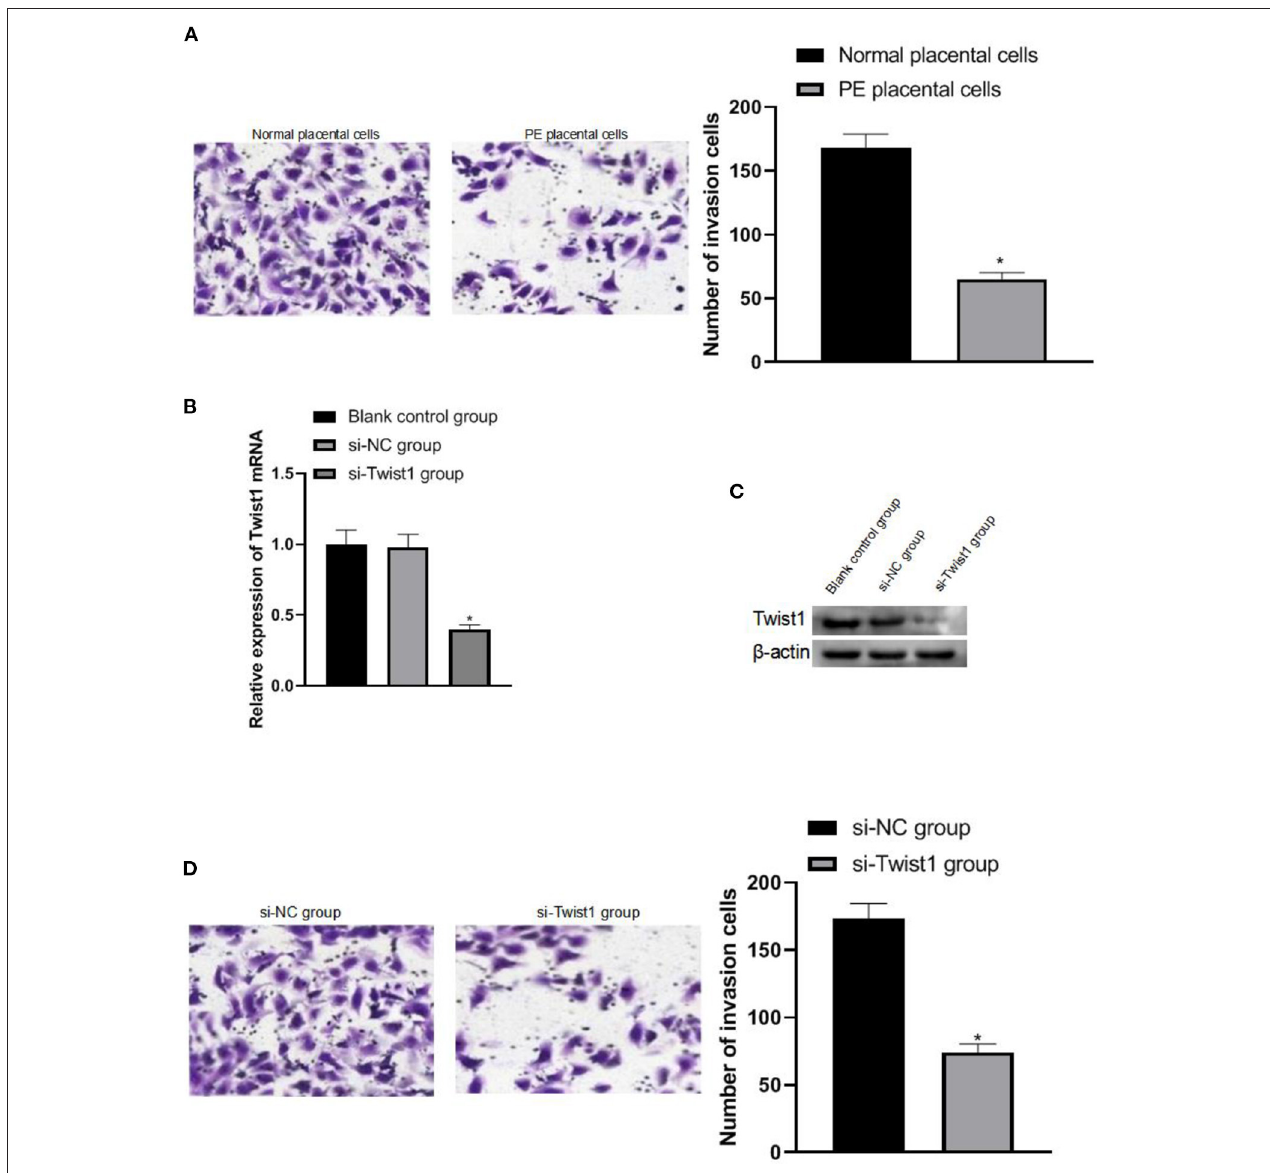
FIGURE 3 | The effect of interference with Twist1 on trophoblast cell invasion. (A) Detection of the invasive ability of trophoblasts; (B,C) The expression of Twist1 mRNA and protein; (D) Detection of the invasive ability of trophoblasts; Compared with Normal placental cells and si-NC group, * p < 0.05.